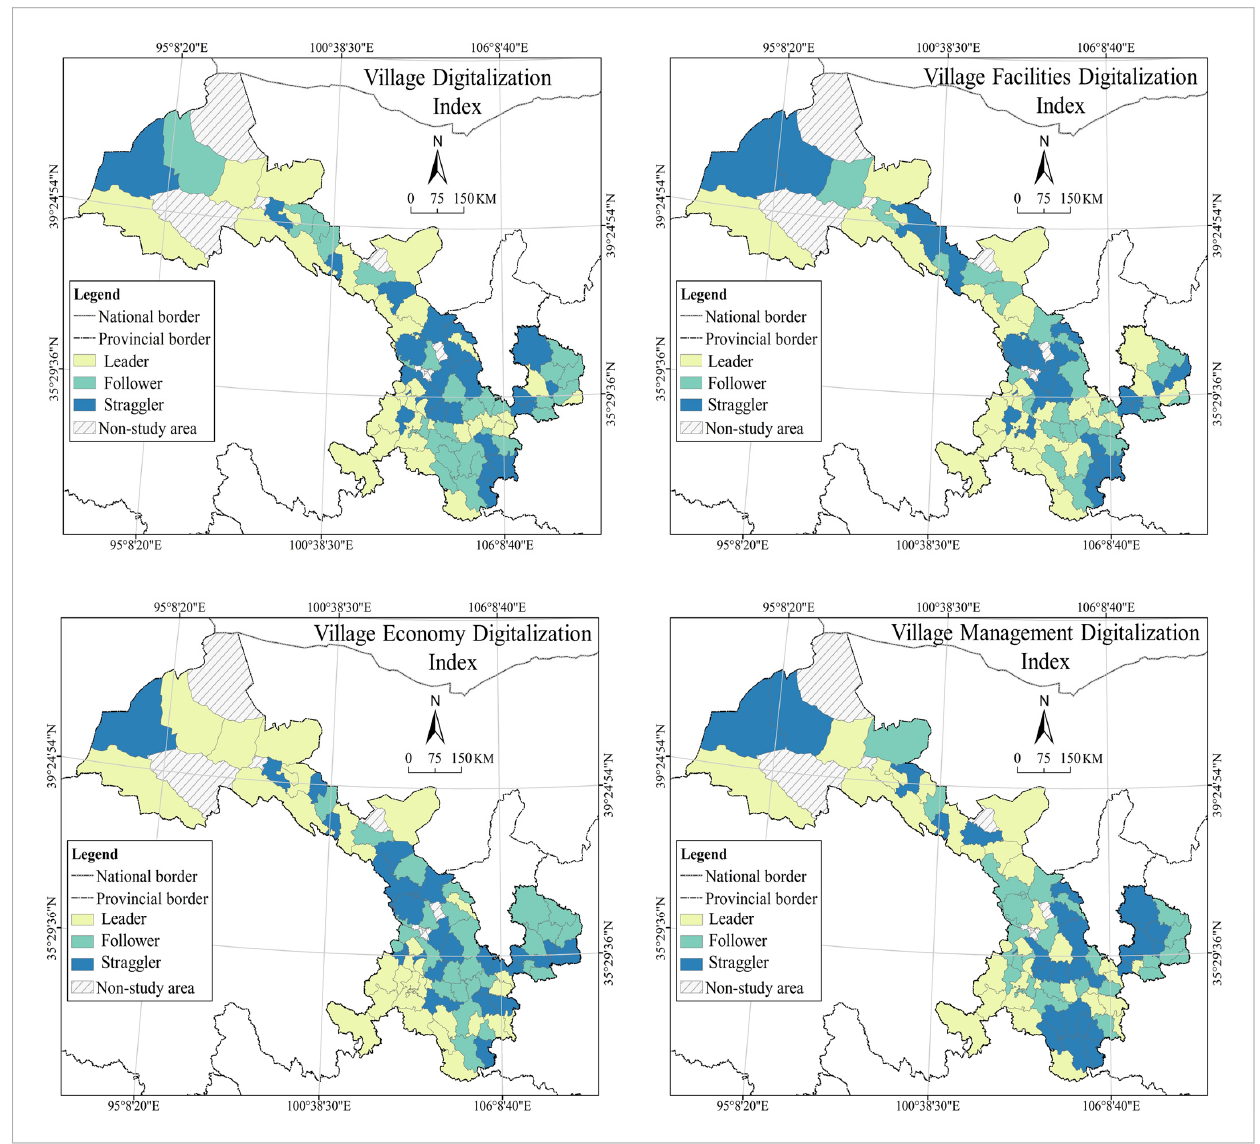
Figure 6. Analysis on development and geographic pattern of village digitalization in Gansu. By use of the spatial hotspot analysis tool, it can be seen that rural digitalization in Gansu Province shows significant spatial agglomeration and correlation, and the geograph- ical distribution of hot and cold counties shows a “center—periphery” spatial